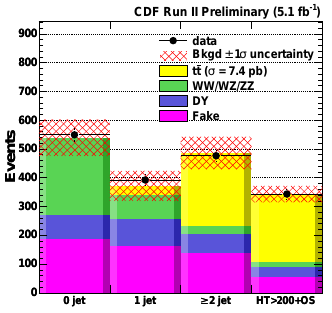
Fig. 2. Jet multiplicity spectrum of pretag events.